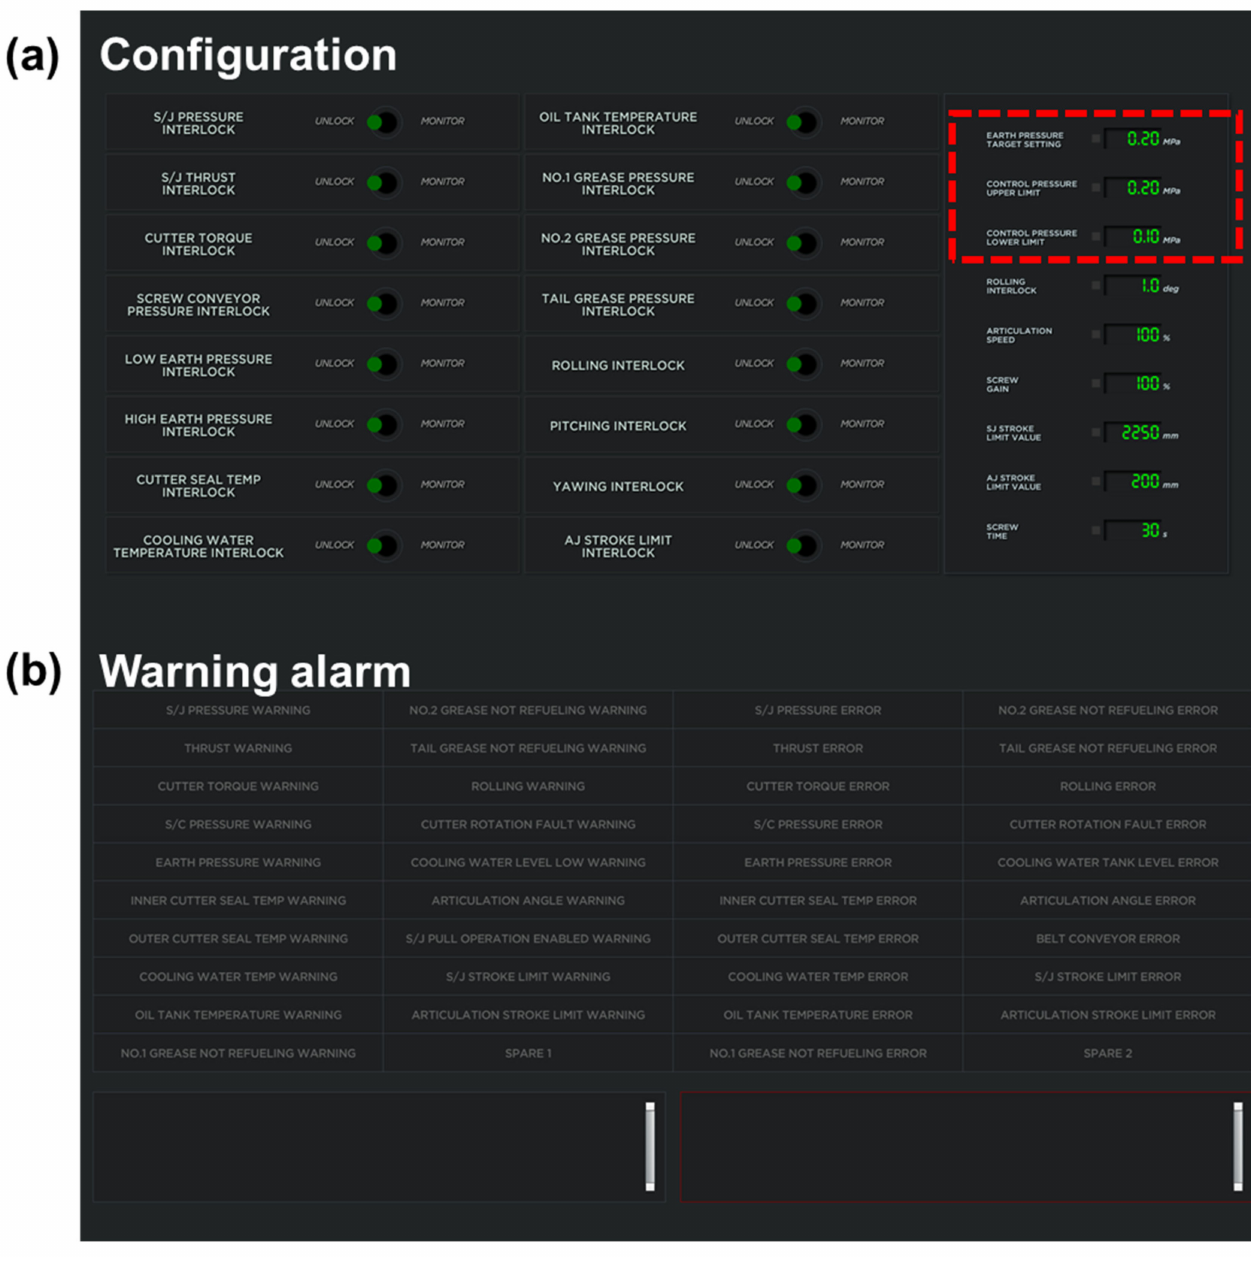
Figure 9. ( a ) Configuration and ( b ) warning alarm panels in the TBM